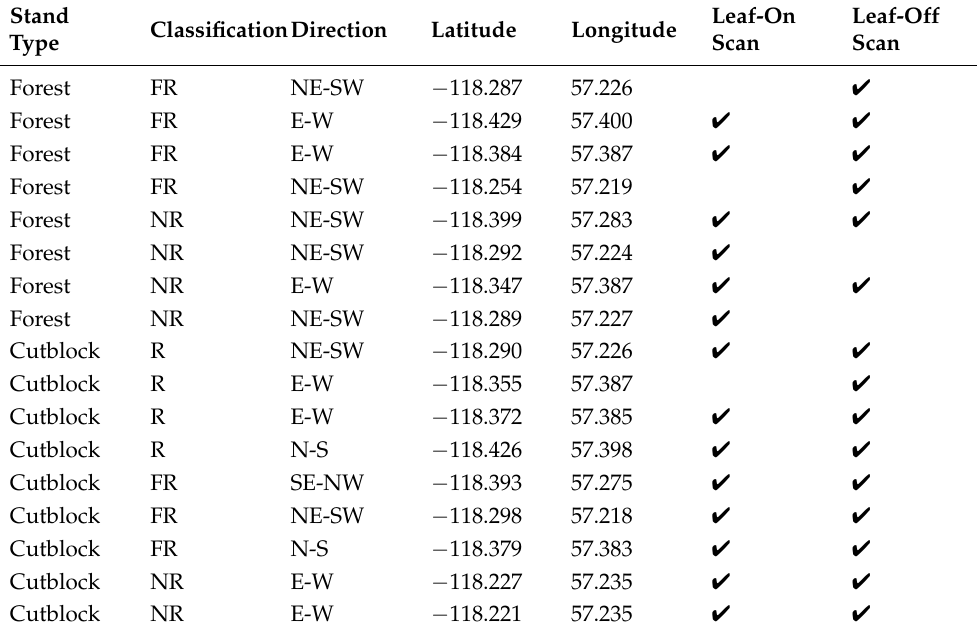
Table A1. Stand type, regeneration classification, and location of all seismic line areas measured, including whether MLS scans were completed in leaf-on (July) and/or leaf-off (October)